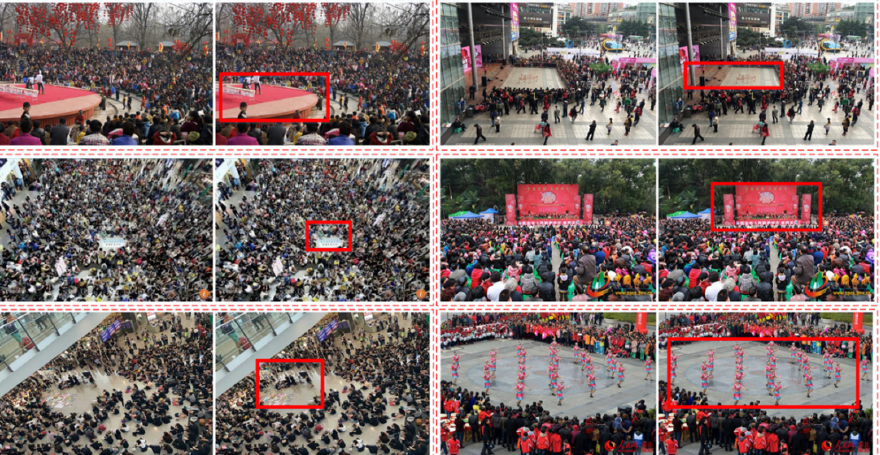
Figure 9. Some examples of the GPIAD dataset. In each dotted rectangle part, the left is the original image and the red full line rectangle on the right is the important area.